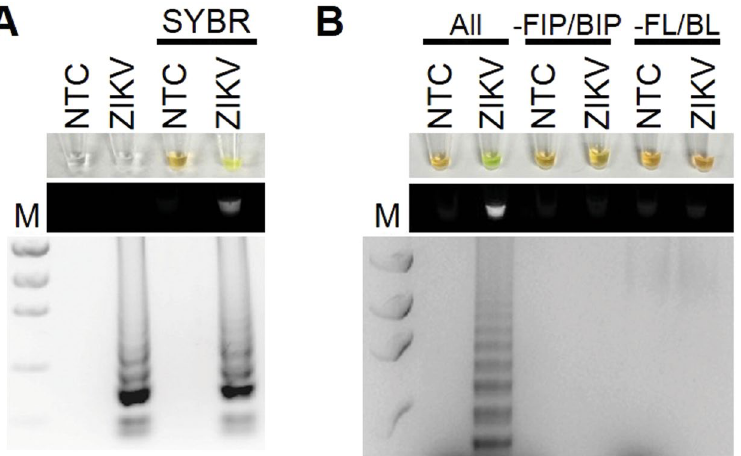
Figure 1. RT-LAMP detection of ZIKV. ( A ) ZIKA RT-LAMP amplification of ZIKV PCR Standard (ZIKV; Robert Koch Institute) but not no template control (NTC; negative control) as visualized by addition of SYBR Green I (SYBR) by eye (upper panel), green fluorescence (middle panel), or gel electrophoresis (bottom panel). Lane M: Low DNA Mass Marker (ThermoFisher Scientific). ( B ) All primers (All) are required for effective LAMP reaction. Reactions without FIP and BIP (-FIP/BIP) or FL and BL (-FL/BL) resulted in a negative RT- LAMP